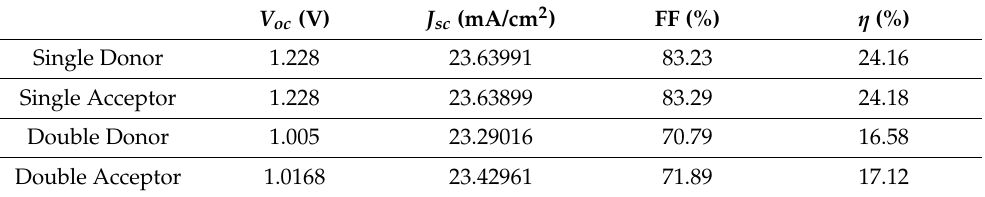
Table 3. Defect state effect on output characteristics of solar cell at trap density 10 15 cm − 3 .